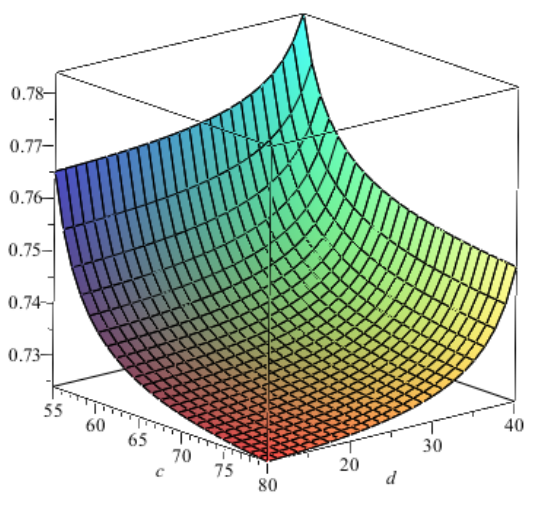
Figure 14: Correlation between preload relaxation and geometries of inner and outer